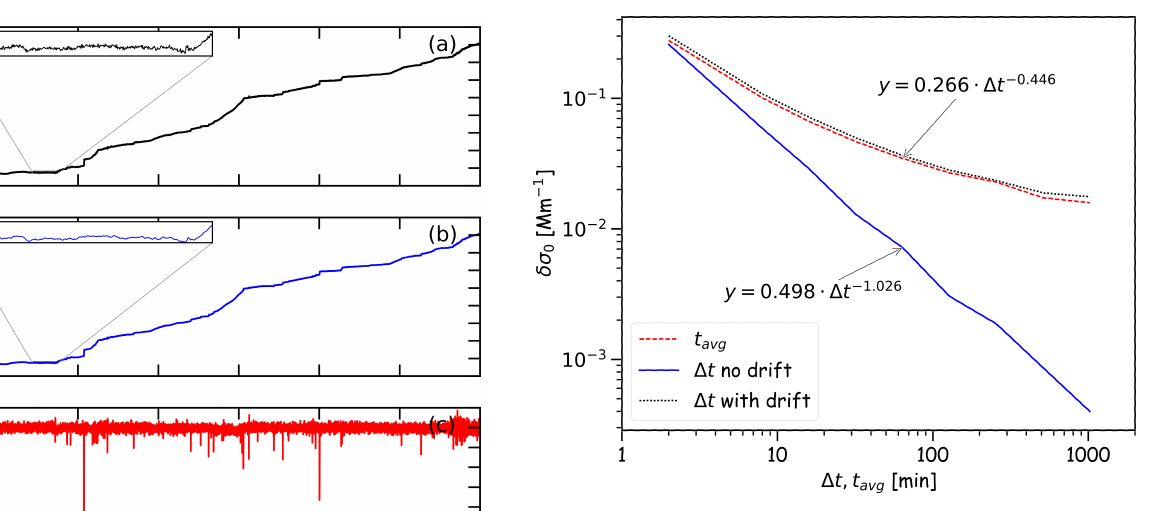
Figure 2. Standard deviation of attenuation coefficients ( δσ 0 ) when measuring particle-free air as a function of collection time ( (cid:49)t) with drift and without drift in the data. The t avg curve is calculated from eBC data as reported by the instrument and converted to σ 0 using a MAC AE of 28.13m 2 g − 1 . The wavelength used to produce the figure is